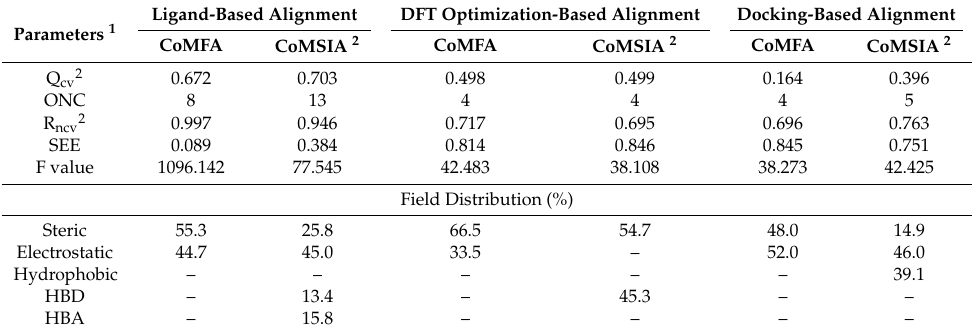
Table 1. Statistical parameters of the CoMFA and CoMSIA models derived from three alignment methods. Parameters 1